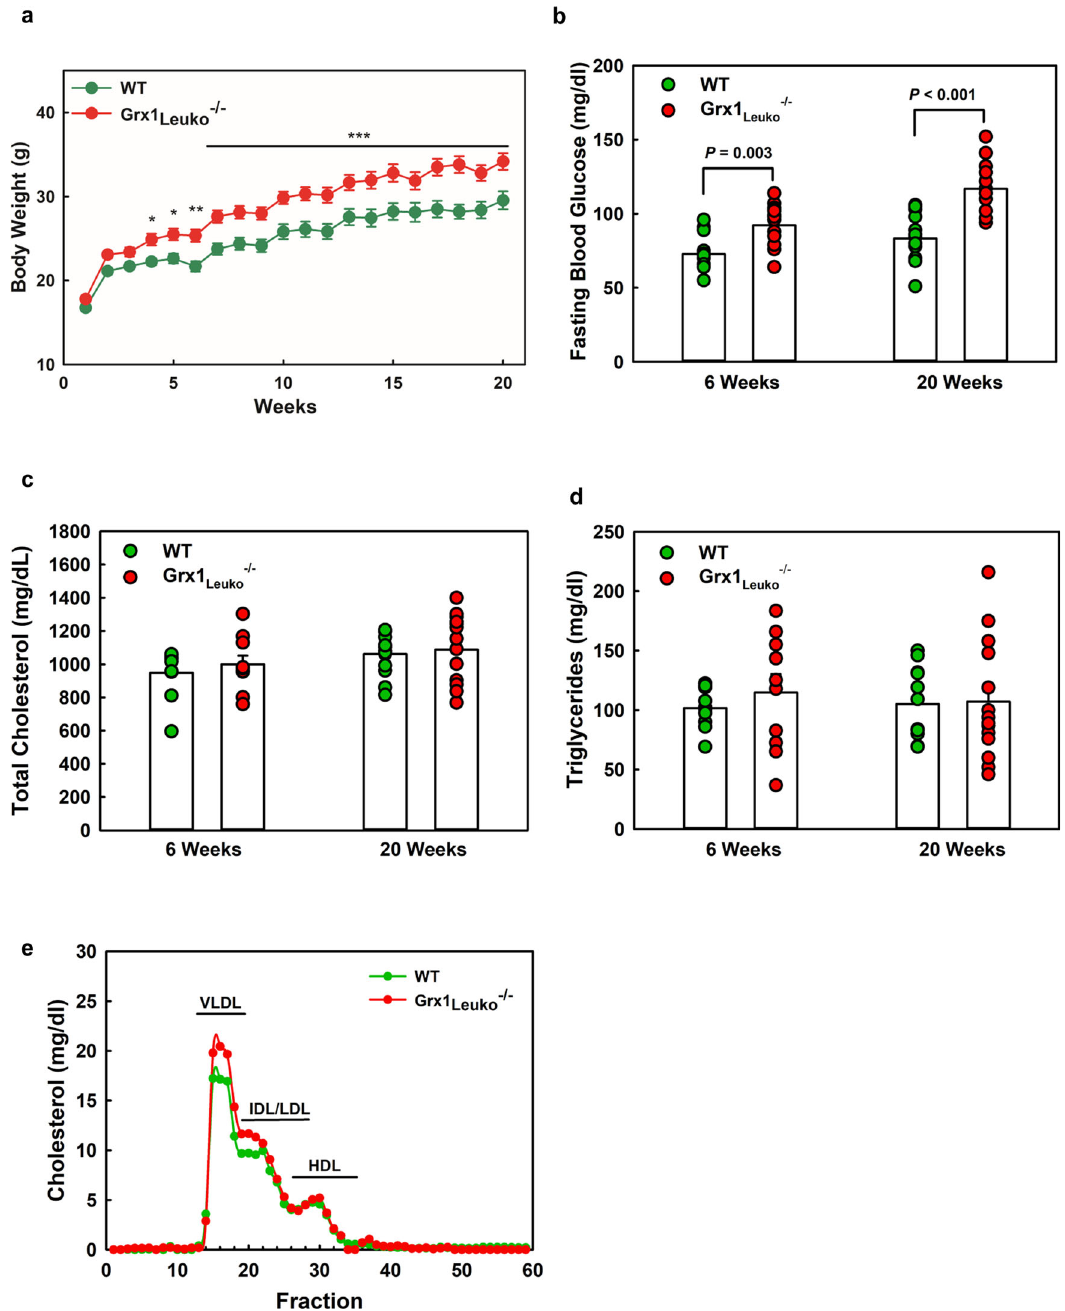
Fig. 7 Hematopoietic Grx1 de fi ciency accelerates body weight gain in reproductively healthy female LDLR -/- mice fed a high-calorie diet. a Body weights. n = 14 per group. b Fasting blood glucose levels. n = 14 per group. c Total cholesterol levels. n = 14 per group. d Total plasma triglyceride levels. n = 14 per group. e Lipoprotein pro fi les of LDLR -/- (WT) and LDLR -/- Grx1 -/- mice (Grx1 -/- ) from pooled plasma samples; n = 14 per group. All data Leuko Leuko are expressed as mean ± S.E. One-way ANOVA followed by Fisher ’ s Least Signi fi cance Difference test was used to compare the mean values between experimental groups. Source data are provided as a Source Data fi